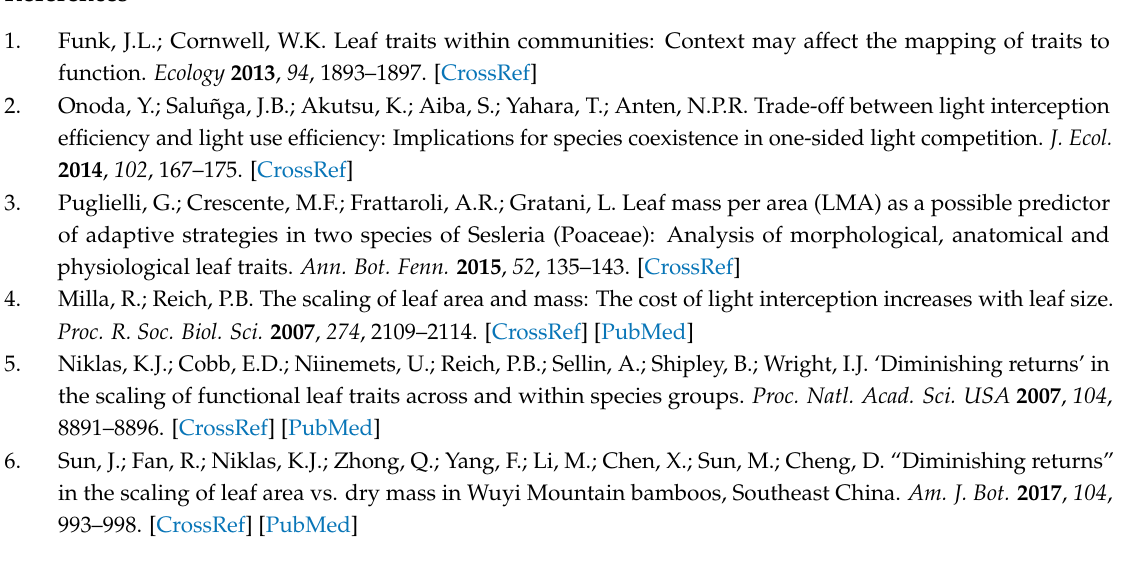
Table S1. Fitted results for the scaling relationships between leaf dry weight and leaf fresh weight of 15 species of plants; Table S2. Fitted results for the scaling relationships between leaf dry weight and area of 15 species of plants; Table S3. Fitted results for the scaling relationships between leaf fresh weight and area of 15 species of